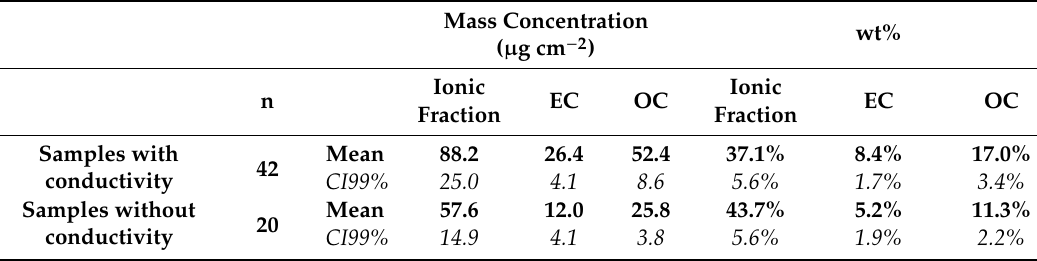
Table 3. The mean mass surficial concentrations for the overall the inorganic ionic fraction (calculated as the sum of F − , Cl − , NO 3 − , SO 42 − , Na + , NH 4+ , K + , Ca 2+ , Mg 2+ ), elemental carbon (EC) and organic carbon (OC) are presented. Weight percentages (wt%) for the inorganic ionic, EC and OC are reported, as well. Average values are reported alongside the corresponding 99% confidence intervals. The whole dataset is split into detected and not-detected samples, in relation to the conductivity measurements in the AEC. n indicates the number of samples in each subset.